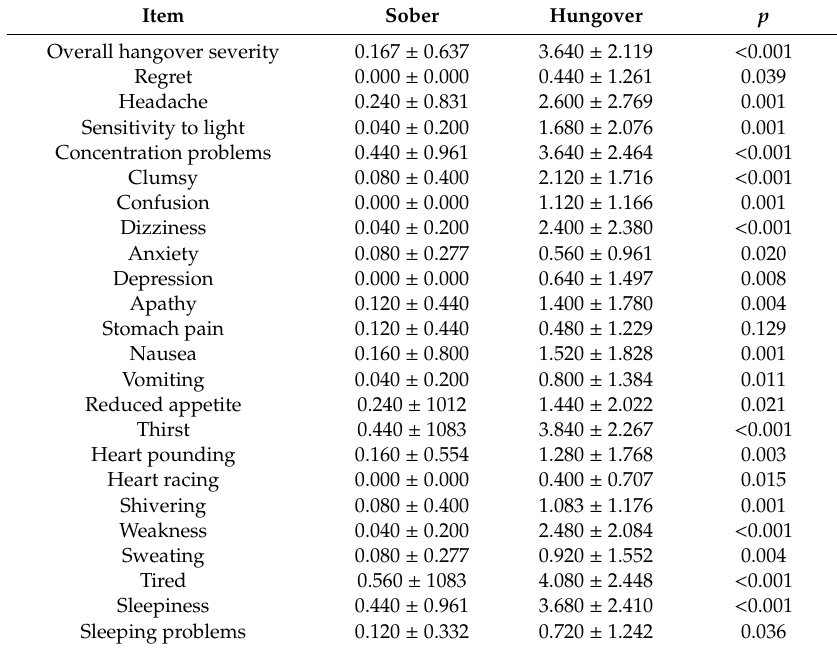
Table 1. Symptom severity ratings on both